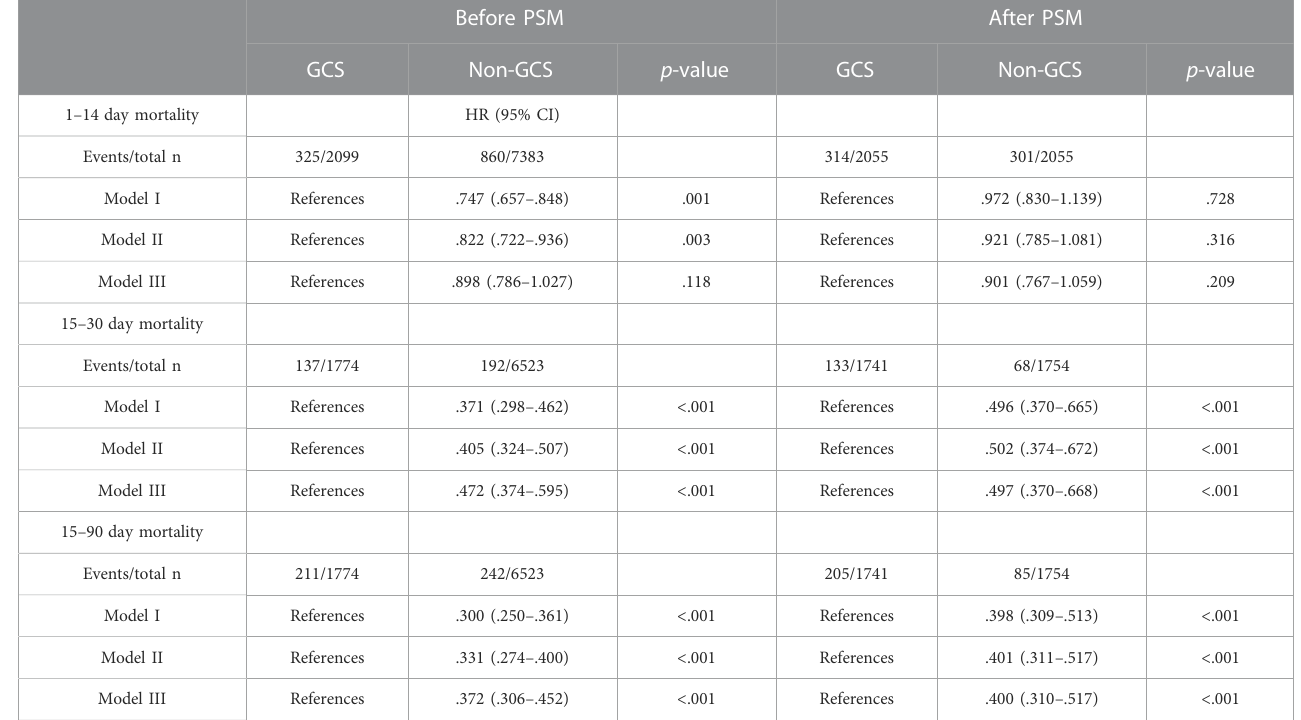
TABLE 3 Association between the non-glucocorticoid group and all-cause mortality.